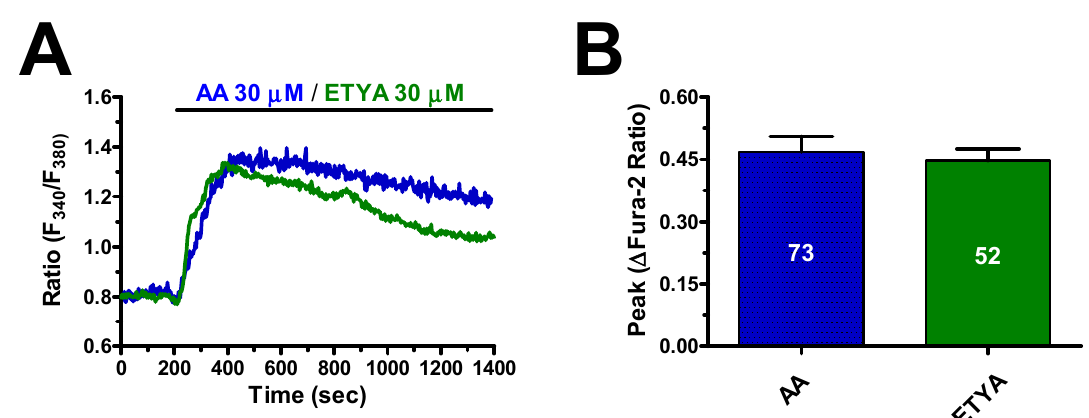
Figure 2. Arachidonic acid (AA) metabolism is not necessary for arachidonic acid-induced elevation in [Ca 2 + ] i in hCMEC / D3 cells. ( A ) 30 µ M eicosatetraynoic acid (ETYA), a non-metabolizable analogue of AA, elicits an intracellular Ca 2 + signal which overlaps with the Ca 2 + response to 30 µ M AA in hCMEC / D3 cells. ( B ) Mean ± SE of the amplitude of ETYA- and AA-induced elevations in [Ca 2 + ] i .